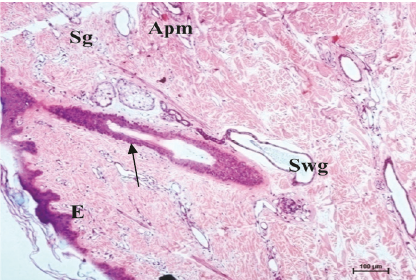
Figure 5: Photomicrographsfrom head ventral region skin showing epidermis (E), hair follicle (arrow), sweat gland (Swg), sebaceous gland (Sg), and arrector pili muscle (Apm). Hematoxylin and eosin X 100.